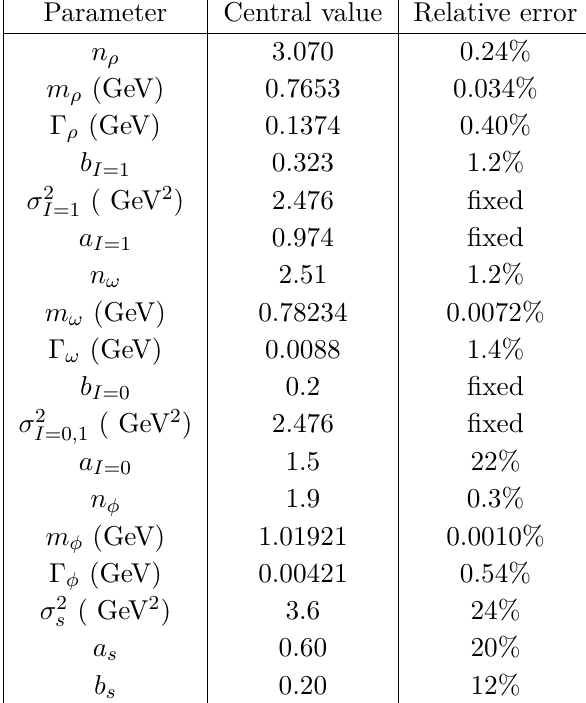
Table 1 . Parameters for the spectral